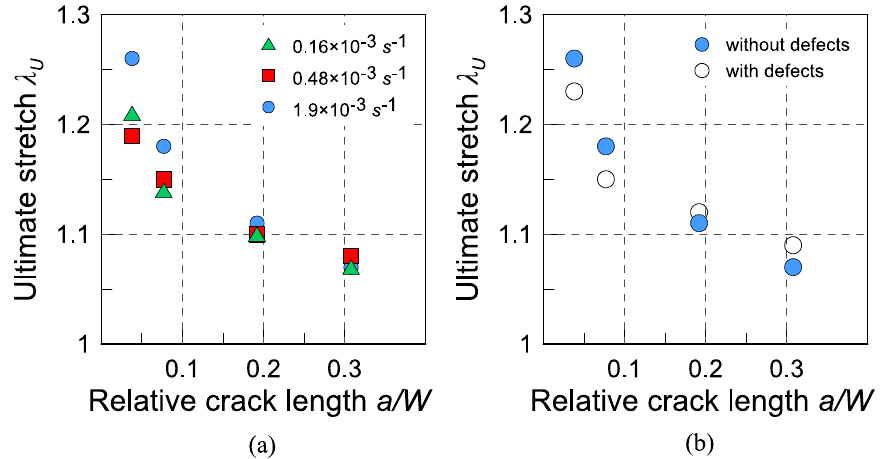
Figure 9. Ultimate stretch vs the initial relative crack size for the edge-cracked samples. ( a ) Effect of the applied strain rate in the specimens EC1–EC4 and ( b ) influence of the material defects, for a strain ε 0 = 1.9 · 10 − 3 s − 1 (results from samples EC1–EC4 are shown as solid circles, and D1–D4 as hollow circles).